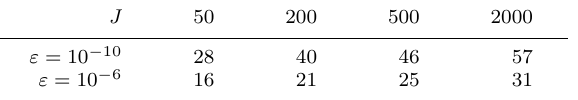
Table 5. Number of iterations on J . Neumann problem, the 9-point solver, 9-point scheme.